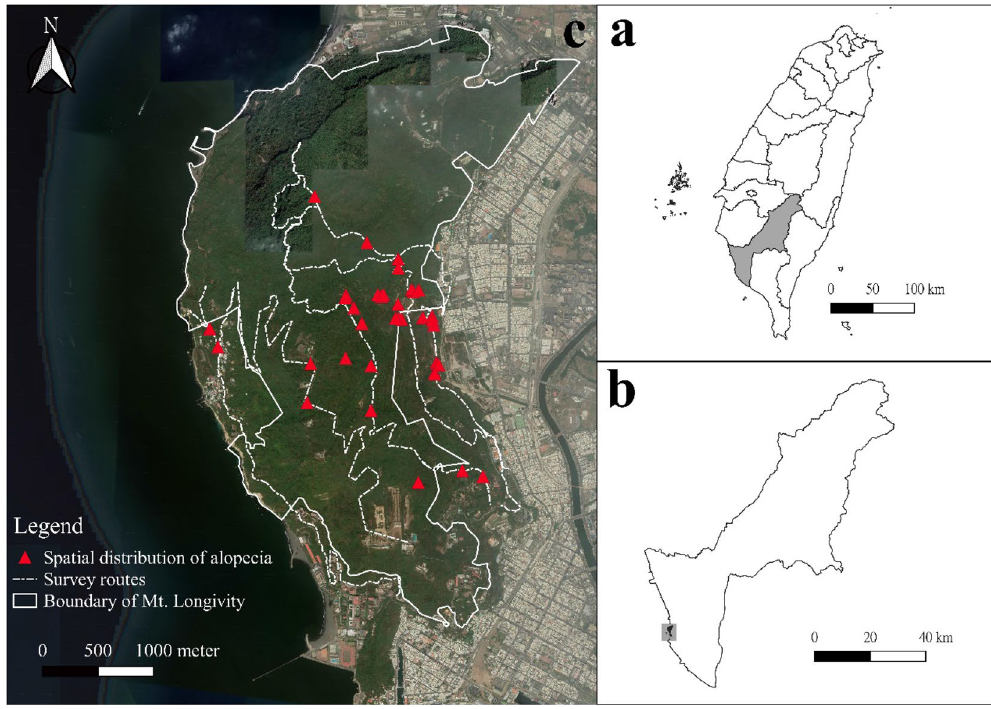
Figure 2. Study area, and the distribution of Formosan macaques with bilateral symmetrical alopecia in Mt. Longevity, SNNP, Taiwan. ( a ) Gray area indicates Kaohsiung city in Taiwan. ( b ) Mt. Longevity (gray area) is located on the west side of Kaohsiung city. ( c ) Map of Mt. Longevity, and the spatial distribution of individuals with bilateral symmetrical